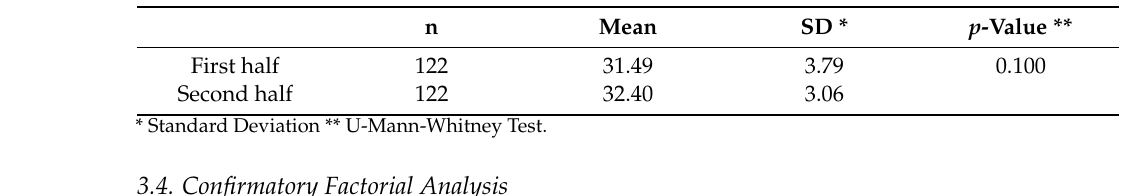
Table 2. Two-halves test.